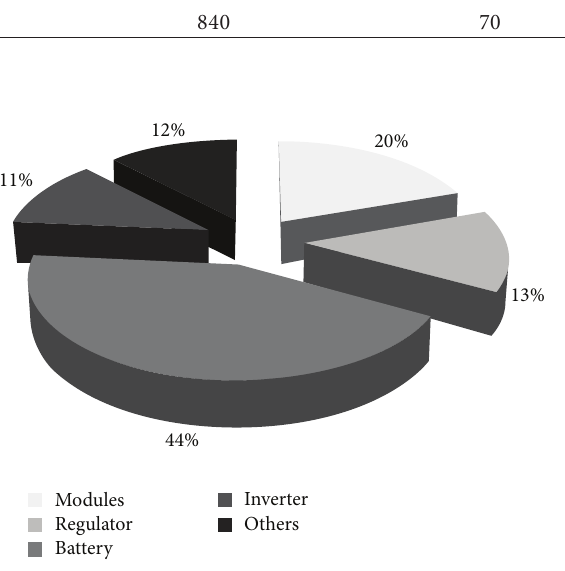
Figure 4: Solar system components costs at the beginning of the project. “Others” represents cables, installation, and